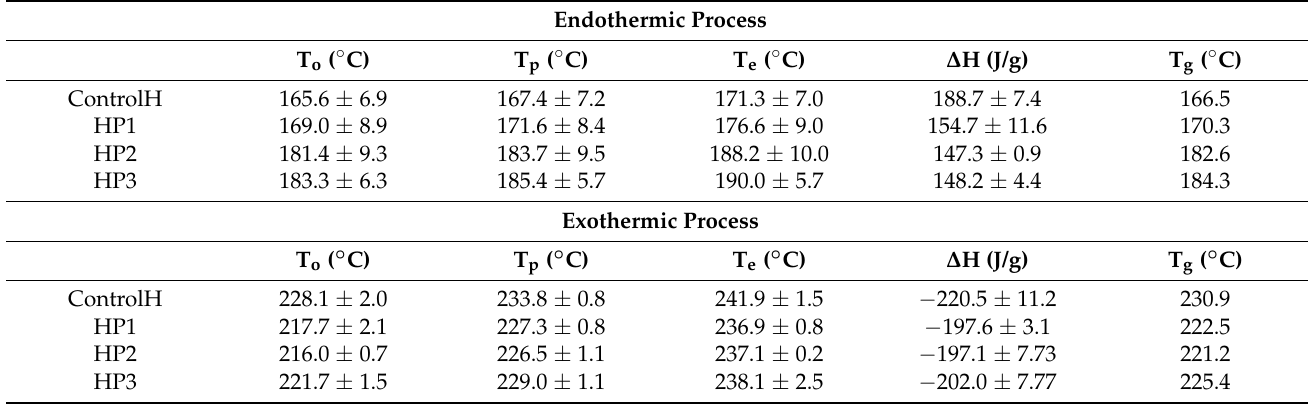
Table 6. Analysis of differential scanning calorimetry of analysis of the films with